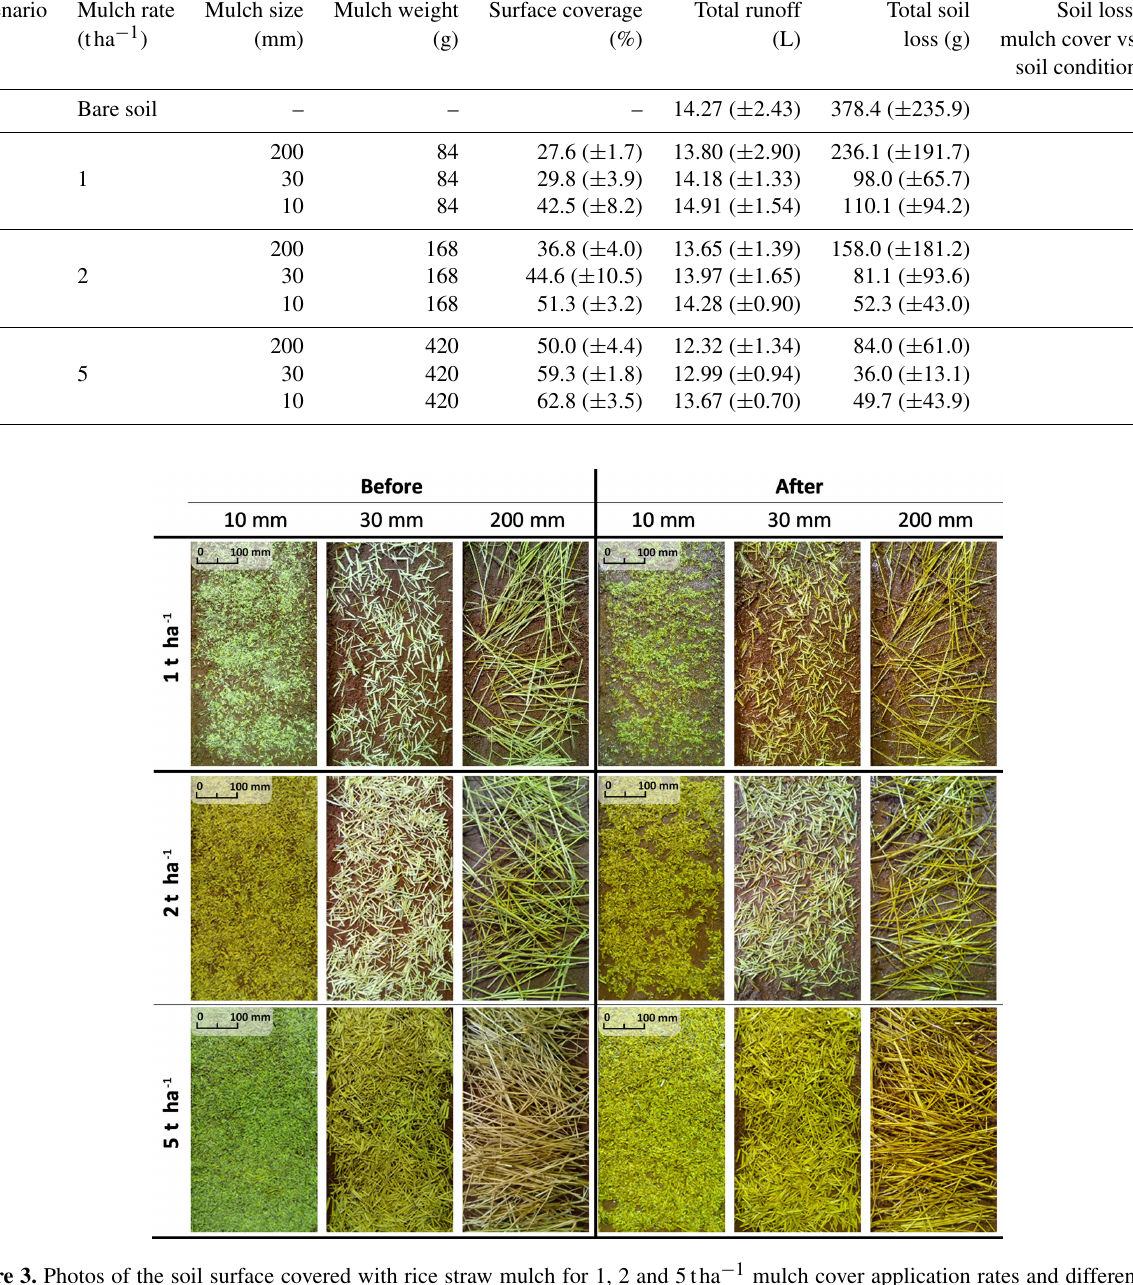
Figure 3. Photos of the soil surface covered with rice straw mulch for 1, 2 and 5tha − 1 mulch cover application rates and different mulch sizes (10, 30 and 200mm), before and after the experimental runs. Soil flume border wall effect is